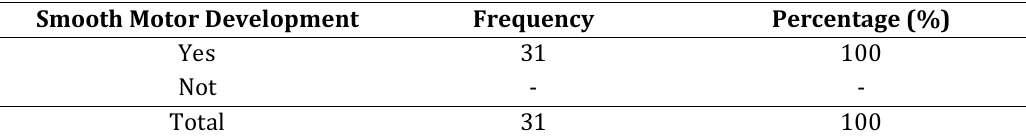
Distribution of Fine Motor Development After Stimulation of Educational Game Tools in Srikandi Kindergarten Lhokseumawe (n=31)